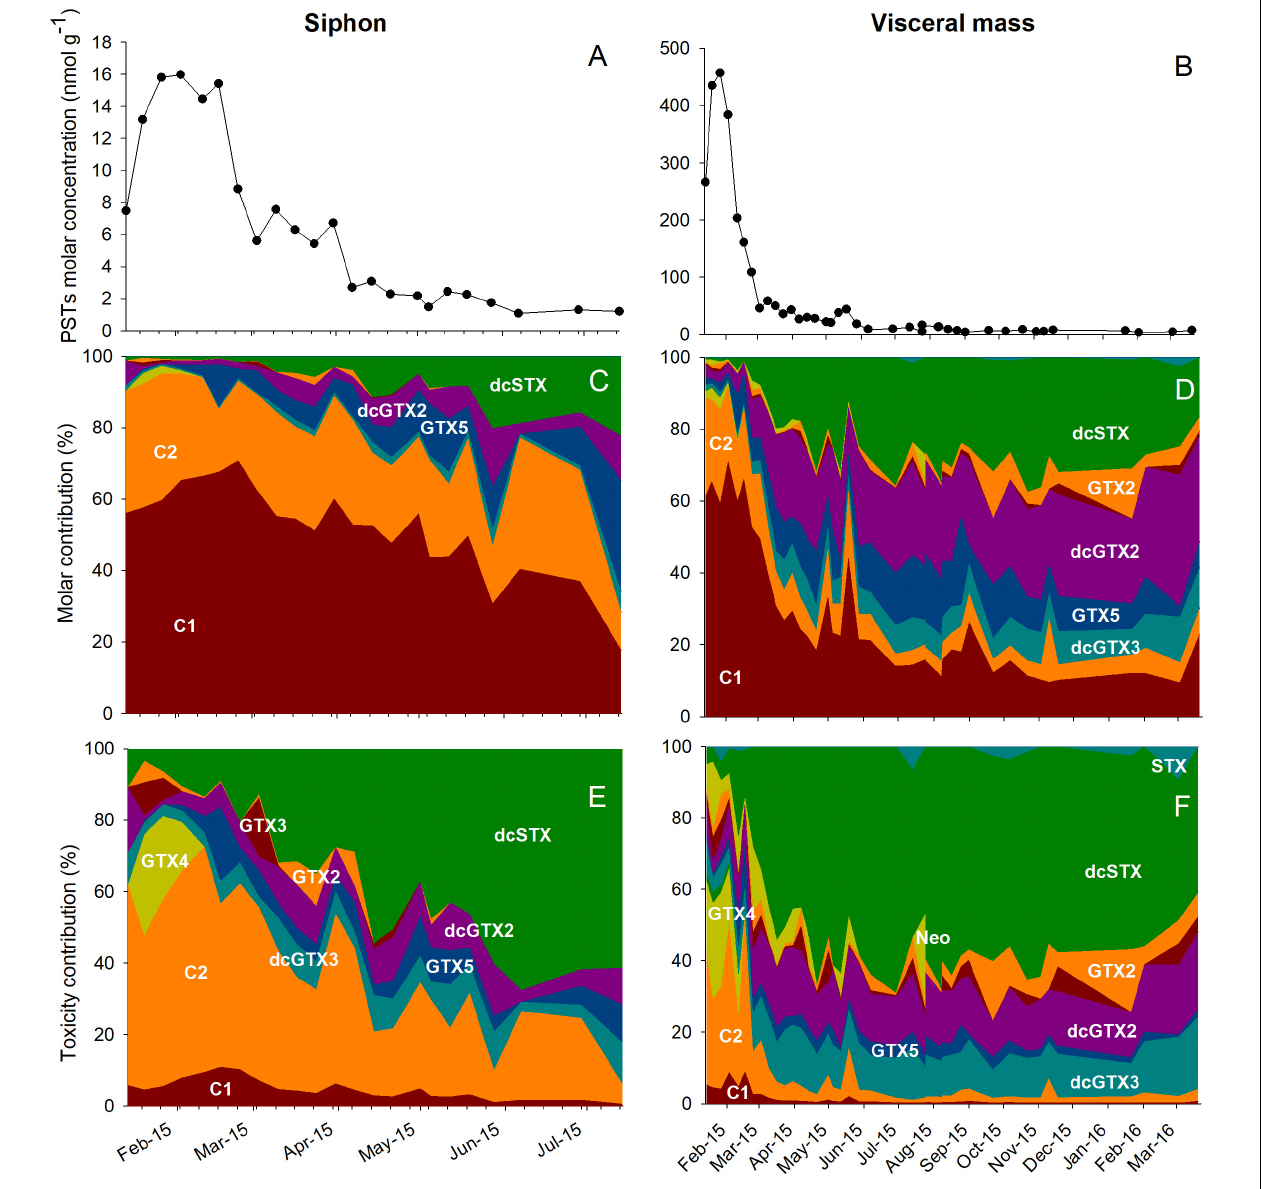
FIGURE 5 | Paralytic toxins in the siphon (A,C,E) and in the visceral mass (B,D,F) of geoduck samples collected from January 2015 to April of 2016. The paralytic toxins molar concentration (nmol g − 1 ) is presented in A and B . The molar contribution (in %, C,D ) and toxicity contribution (in %, E,F ) of different paralytic toxins analogs detected during the sampling period is also shown. The toxicity of each analog was calculated according to the toxin equivalent factors shown in Table 1 .